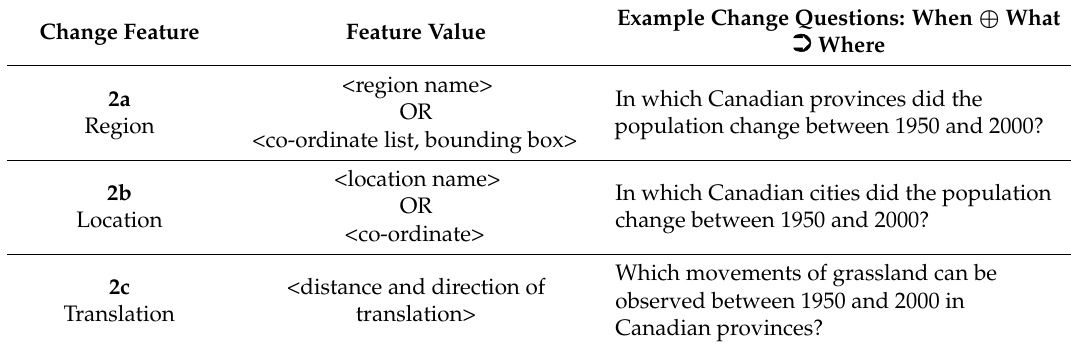
Table 2. Characteristics of “Where” output clauses. Table 1. Characteristics of “What” output